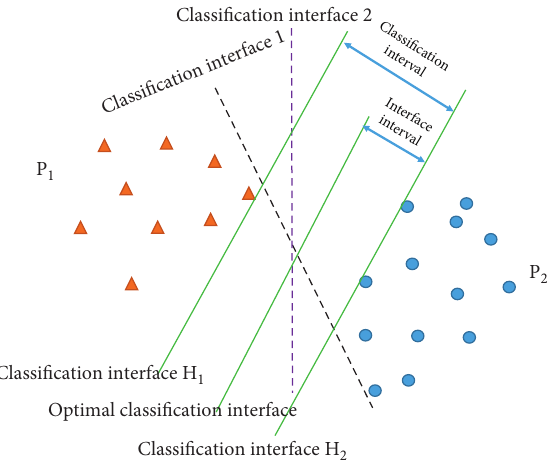
Figure 2: Schematic diagram of classification